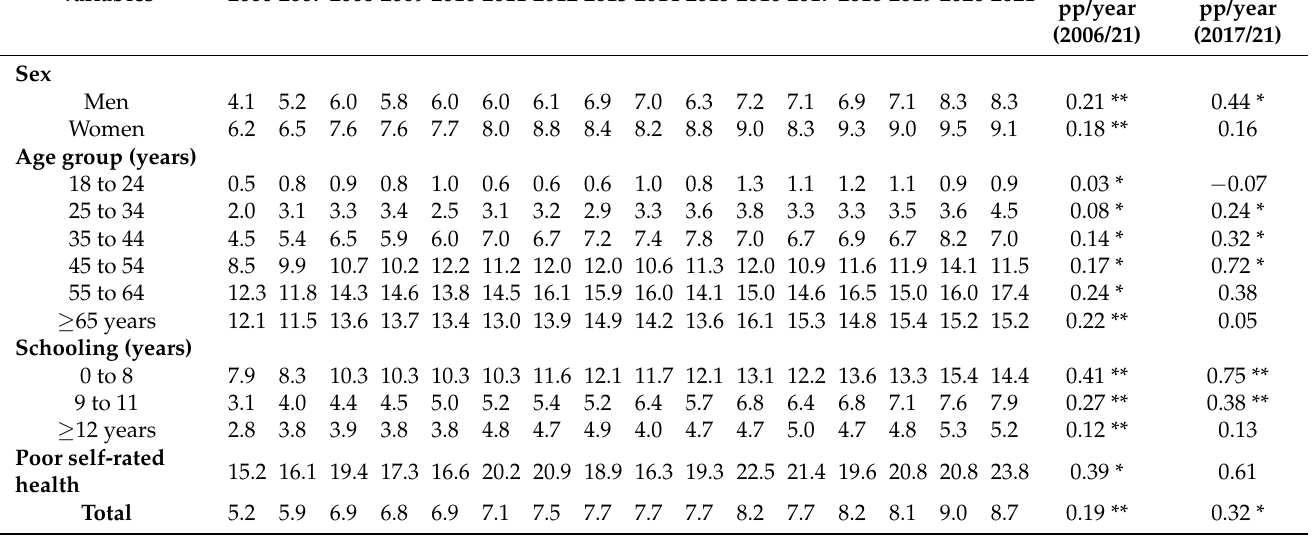
Table 3. Prevalence (%) of co-occurrence of obesity and hypertension among Brazilian adults ( ≥ 18 years), by year, according to sociodemographic characteristics and self-rated health. Vigi- tel Brazil, 2006–2021.